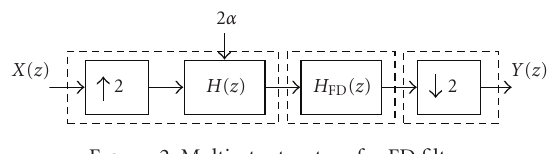
Figure 2: Multirate structure for FD filter.